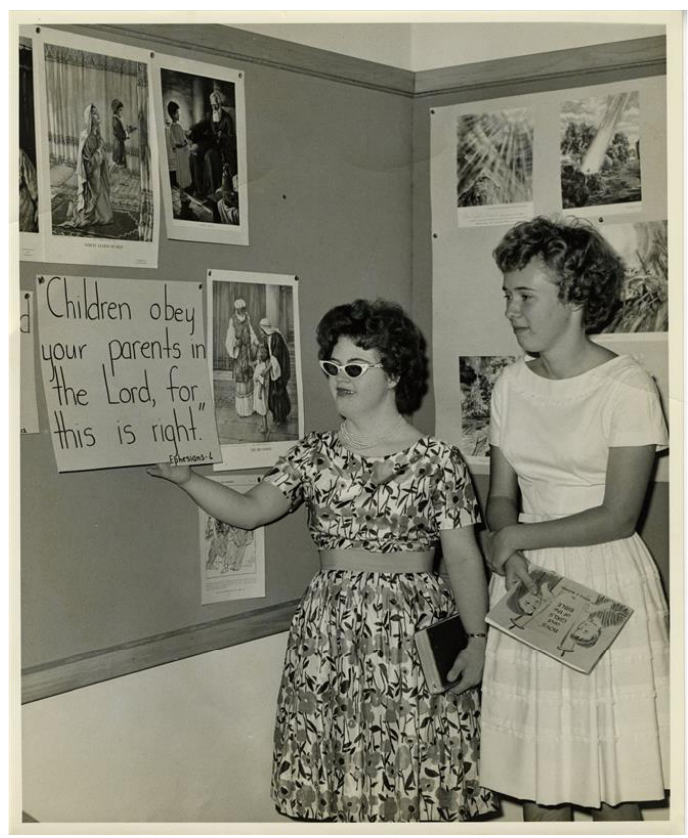
Figure 5: Dona and a classmate at a private school, circa 1960. Courtesy: Sophie Sartain At the same time, we currently face a crisis in housing for aging Americans with disabilities. I wanted to spotlight this issue, too. In the film, when Mimi’s difficulties in caring for Dona increase, my brother expresses frustration about the waitlists at community homes for people like my aunt Dona. He says, “three years, five years. We don’t have five years. We might not even have five months.” It was in this context that we had to act quickly to find a home for